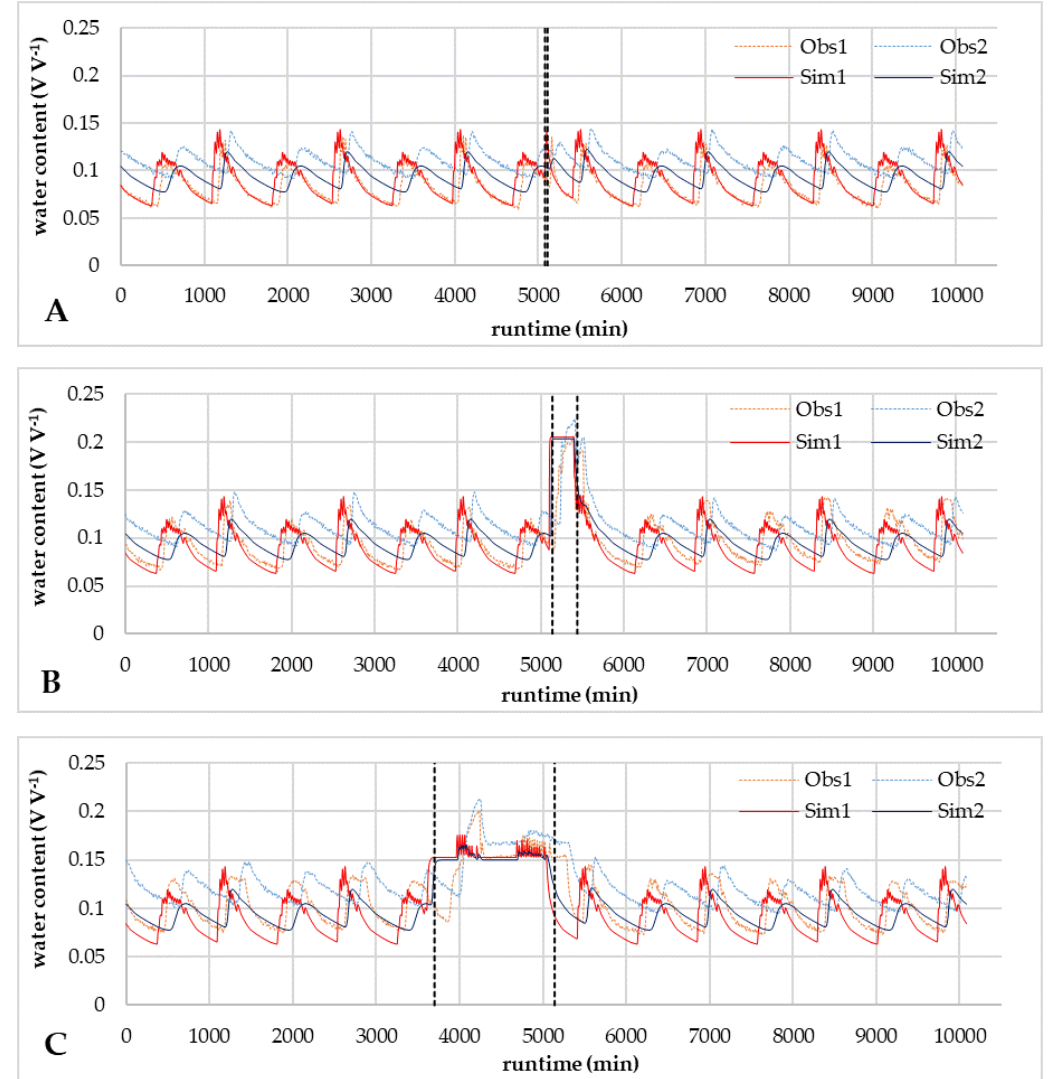
Figure 3. Observed and simulated water contents before, during, and after precipitation event 1 ( A ), event 2 ( B ), and event 3 ( C ) for soil 4 for the upper (Obs1 and Sim1) and lower (Obs2 and Sim2) observation points.